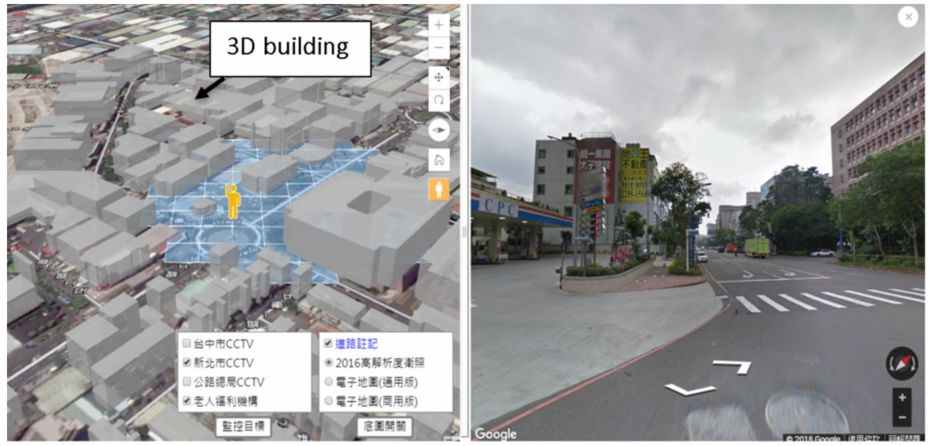
Figure 16. Three-dimensional buildings and a Google Street View map of Wugu